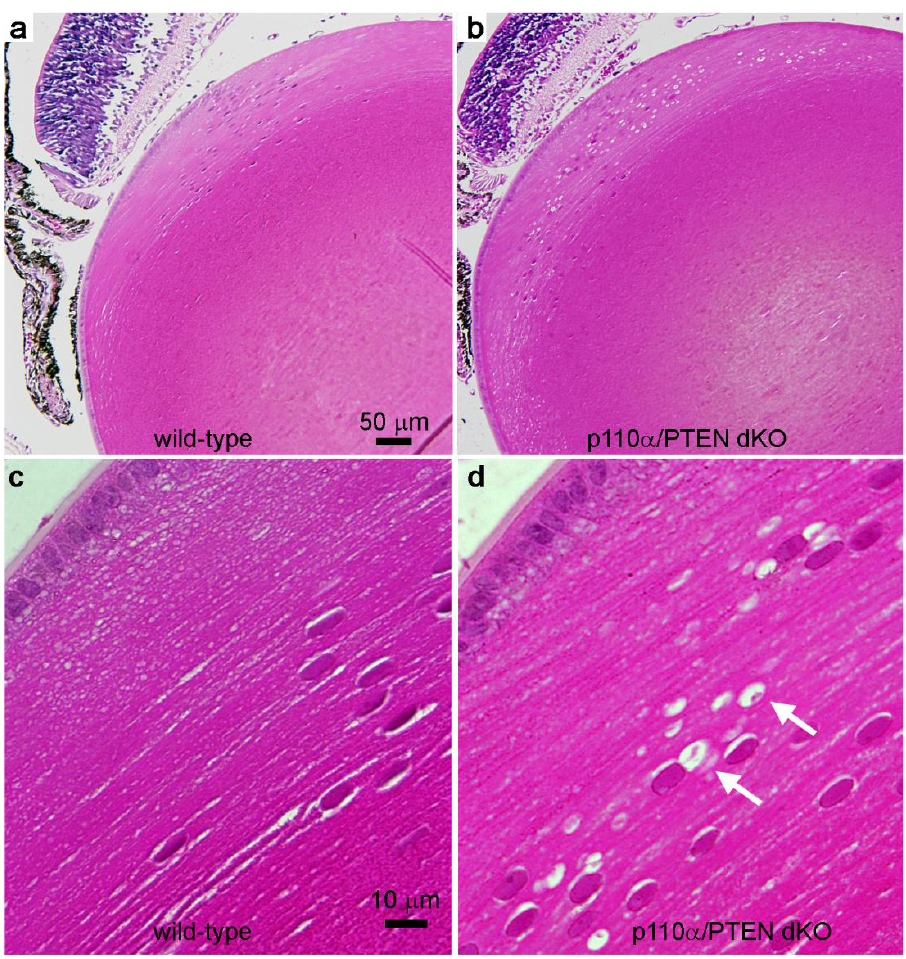
Figure 6. Postnatal day 7 lenses were fixed, embedded in paraffin, sectioned, and stained with hematoxylin and eosin. ( a ) Sagittal sections through the central region of wild-type lenses showed a normal appearance. ( b ) p110α/PTEN dKO lenses had numerous small vacuoles in the cortical region. ( c ) Higher power view of the cortex region of the wild-type lens shown in panel a. Higher power view of the cortex region of the p110α/PTEN dKO lens in panel b, showing the location of small vacuoles in the cortical fiber cells (white arrows). ( a , b ) Bar = 50 µm. ( c , d ) Bar = 10 µm.